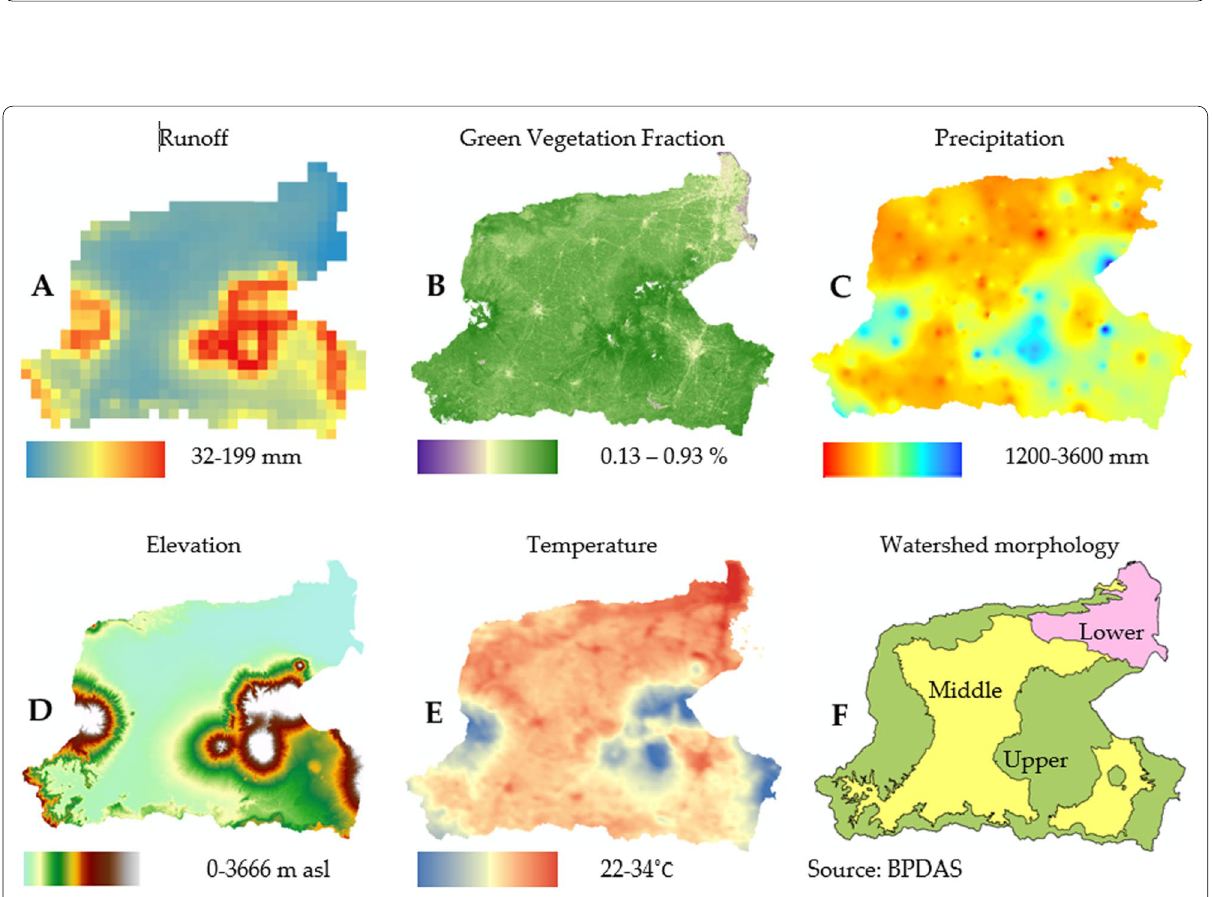
Fig. 6 Comparative runoff magnitudes among three morphological watershed zones: total annual runoff all year, in dry seasons, and in wet seasons 2001–2020